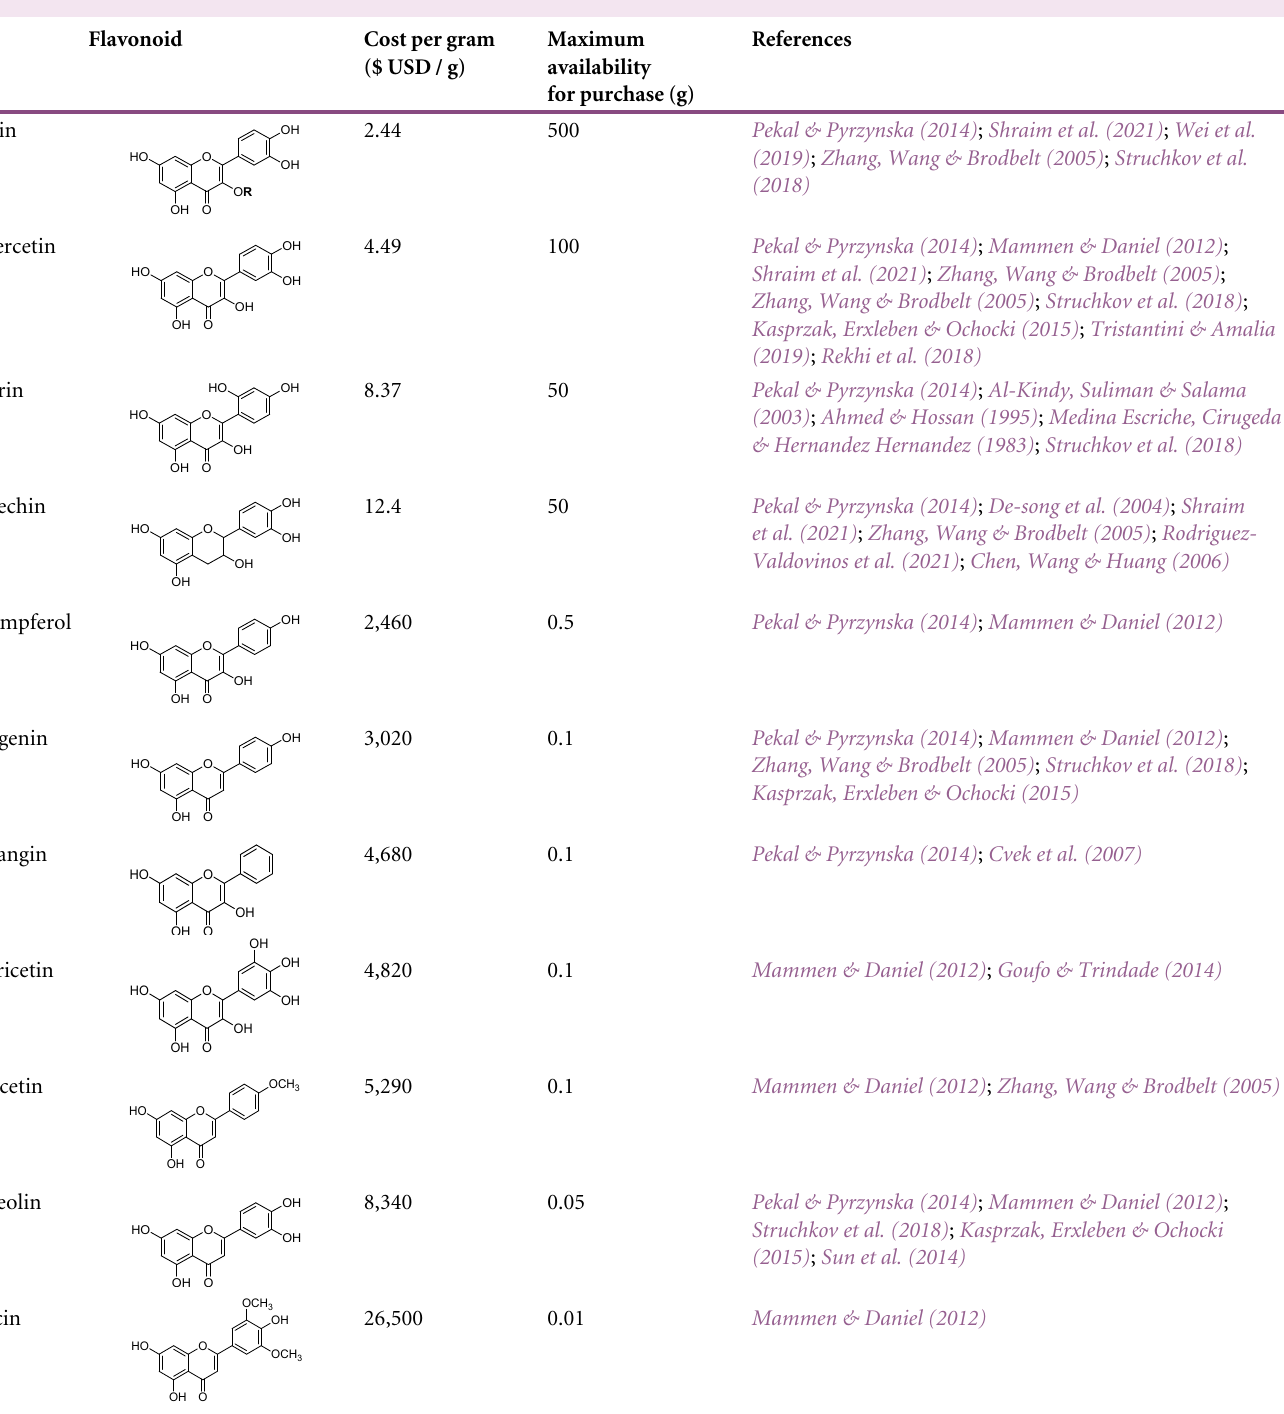
Table 2 Cost and availability of Al 3 + chelating flavonoids (Sigma Aldrich, August 2021). Table 2. Cost and availability of Al 3+ chelating flavonoids (Sigma Aldrich, August 2021) Table 2. Cost and availability of Al 3+ chelating flavonoids (Sigma Aldrich, August 2021) Table 2. Cost and availability of Al 3+ chelating flavonoids (Sigma Aldrich, August 2021) Table 2. Cost and availability of Al 3+ chelating flavonoids (Sigma Aldrich, August 2021) Flavonoid Table 2. Cost and availability of Al 3+ chelating flavonoids (Sigma Aldrich, August 2021) Flavonoid Table 2. Cost and availability of Al 3+ chelating flavonoids (Sigma Aldrich, August 2021) Table 2. Cost and availability of Al 3+ chelating flavonoids (Sigma Aldrich, August 2021) Table 2. Cost and availability of Al 3+ chelating flavonoids (Sigma Aldrich, August 2021) Table 2. Cost and availability of Al 3+ chelating flavonoids (Sigma Aldrich, August 2021) Table 2. Cost and availability of Al 3+ chelating flavonoids (Sigma Aldrich, August 2021) Table 2. Cost and availability of Al 3+ chelating flavonoids (Sigma Aldrich, August 2021) Flavonoid Flavonoid Flavonoid Flavonoid Flavonoid Flavonoid Flavonoid Flavonoid